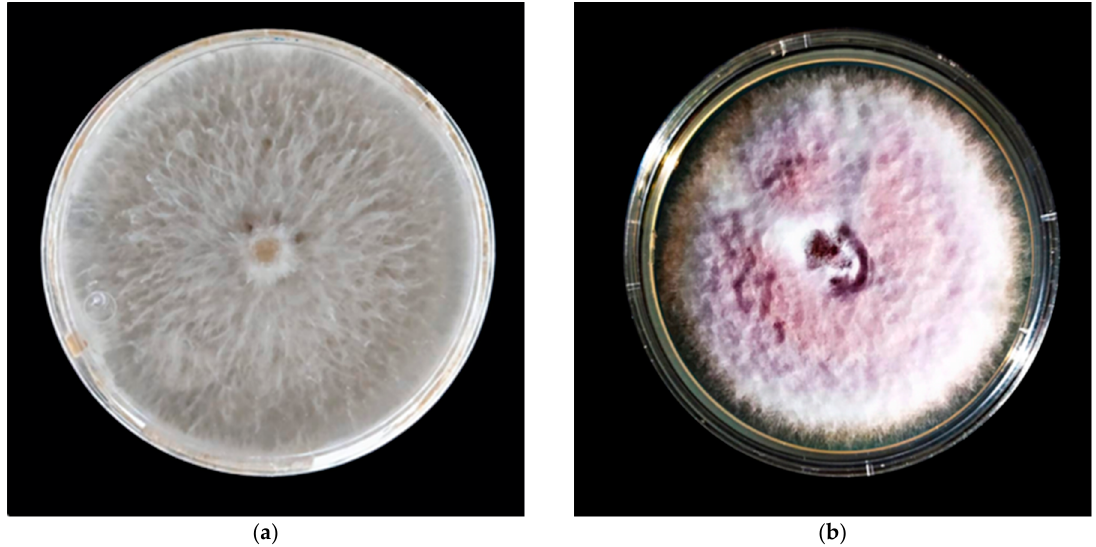
Figure 12. Characteristic mycelial growth at 15 d in PDA medium. ( a ) C. gloeosporioides and ( b ) F. oxysporum .